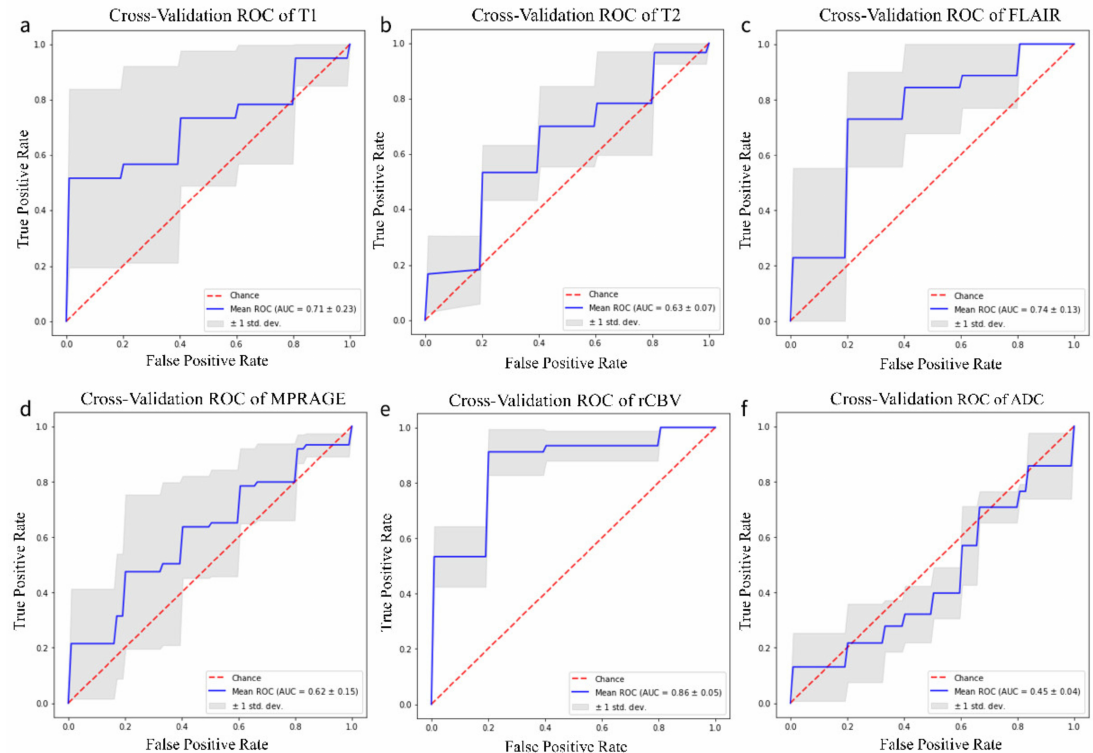
Figure 3. ROC curve for testing set from k-fold cross validation (k = 5) training on T1-weighted magnetic resonance imaging (MRI) sequence ( a ), T2-weighted MRI sequence ( b ), FLAIR MRI sequence ( c ), MPRAGE MRI sequence ( d ), rCBV MRI sequence ( e ), ADC MRI sequence ( f ).